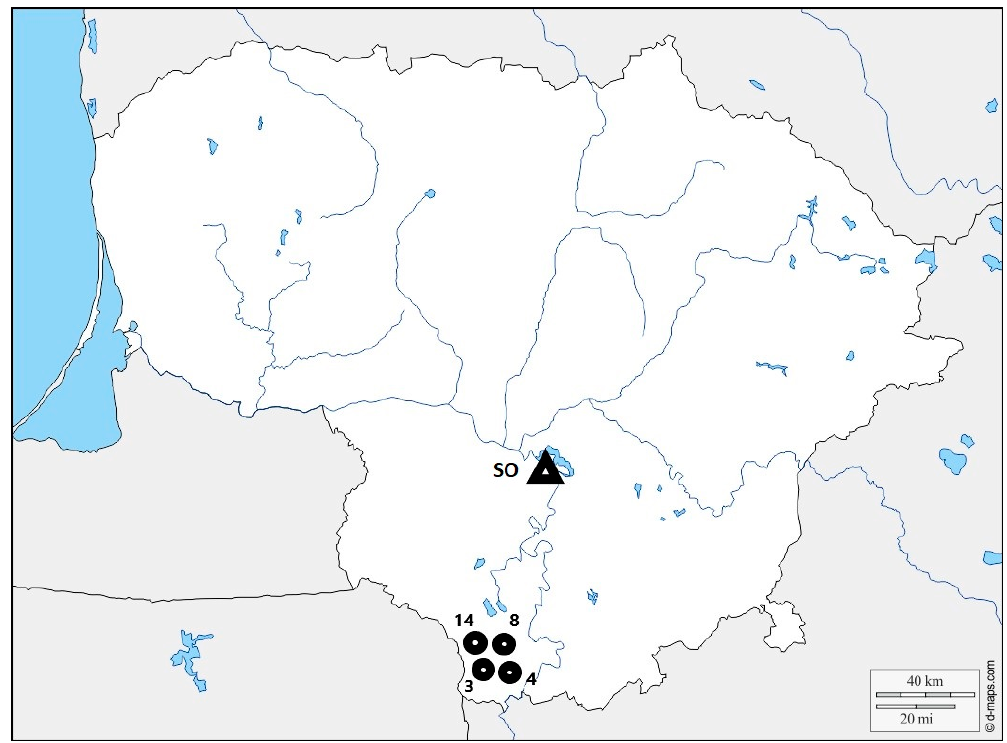
Figure 1. Map of Lithuania showing the study site: potentially resistant to root rot Scots pine clones